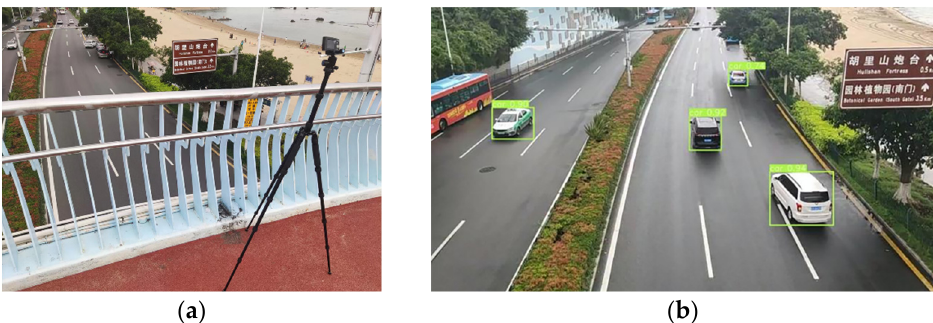
Figure 14. ( a ) Camera on pedestrian overpass. ( b )Detection of vehicles in field measurement.